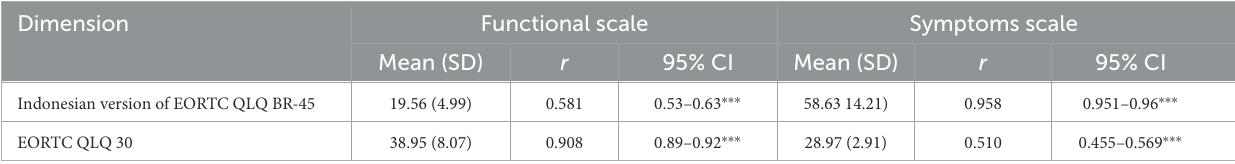
TABLE 4 Convergent validity on Indonesian EORTC QLQ BR45 ( n =